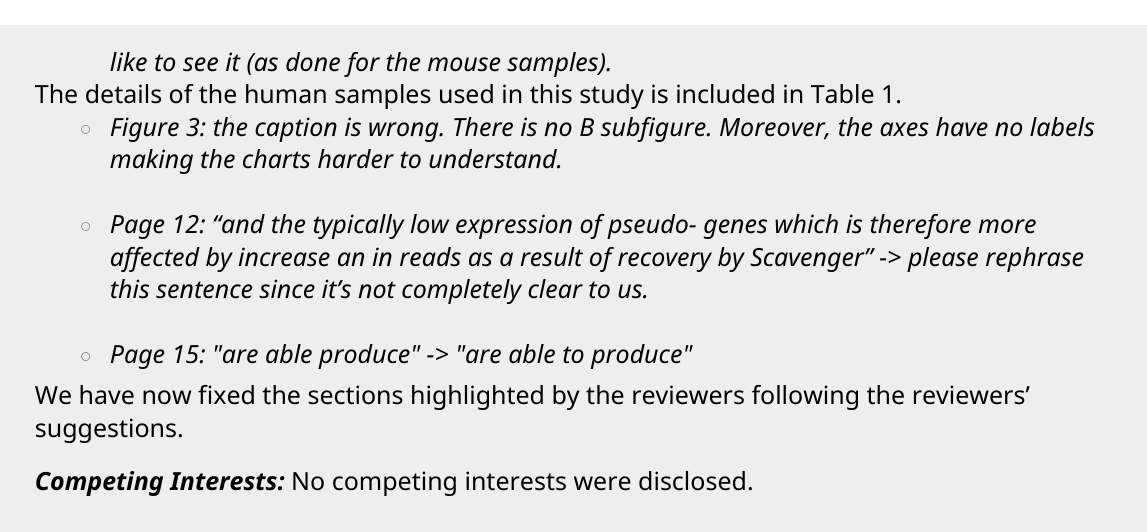
Figure 3: the caption is wrong. There is no B subfigure. Moreover, the axes have no labels making the charts harder to